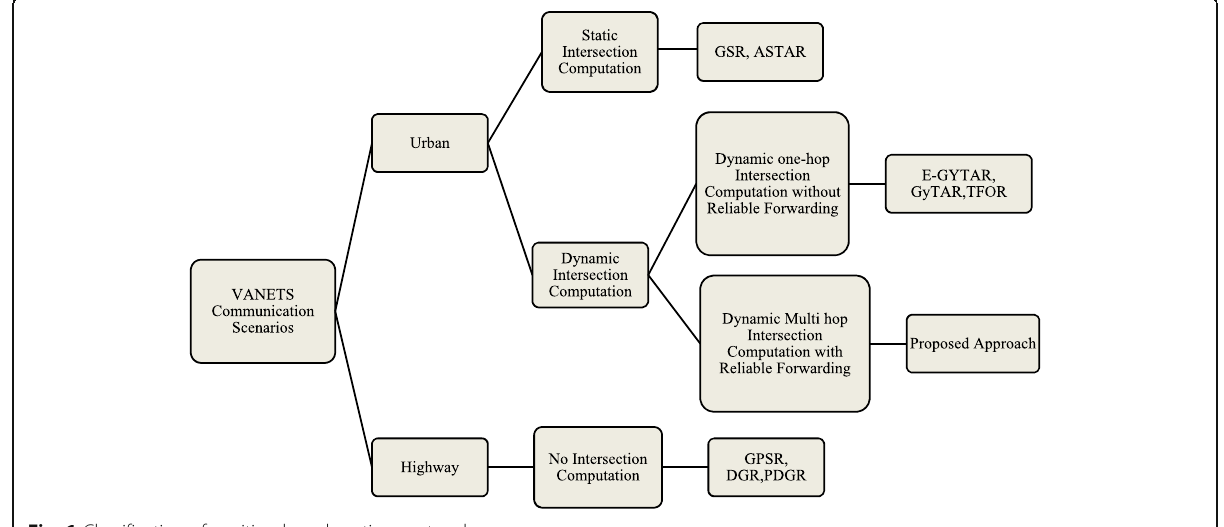
Fig. 1 Classification of position-based routing